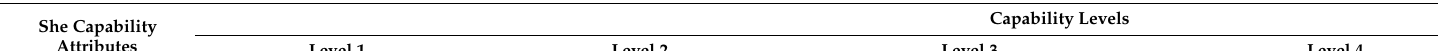
Table A1. Cont. Integrated Safety, Health and Environmental Management Capability Maturity Model